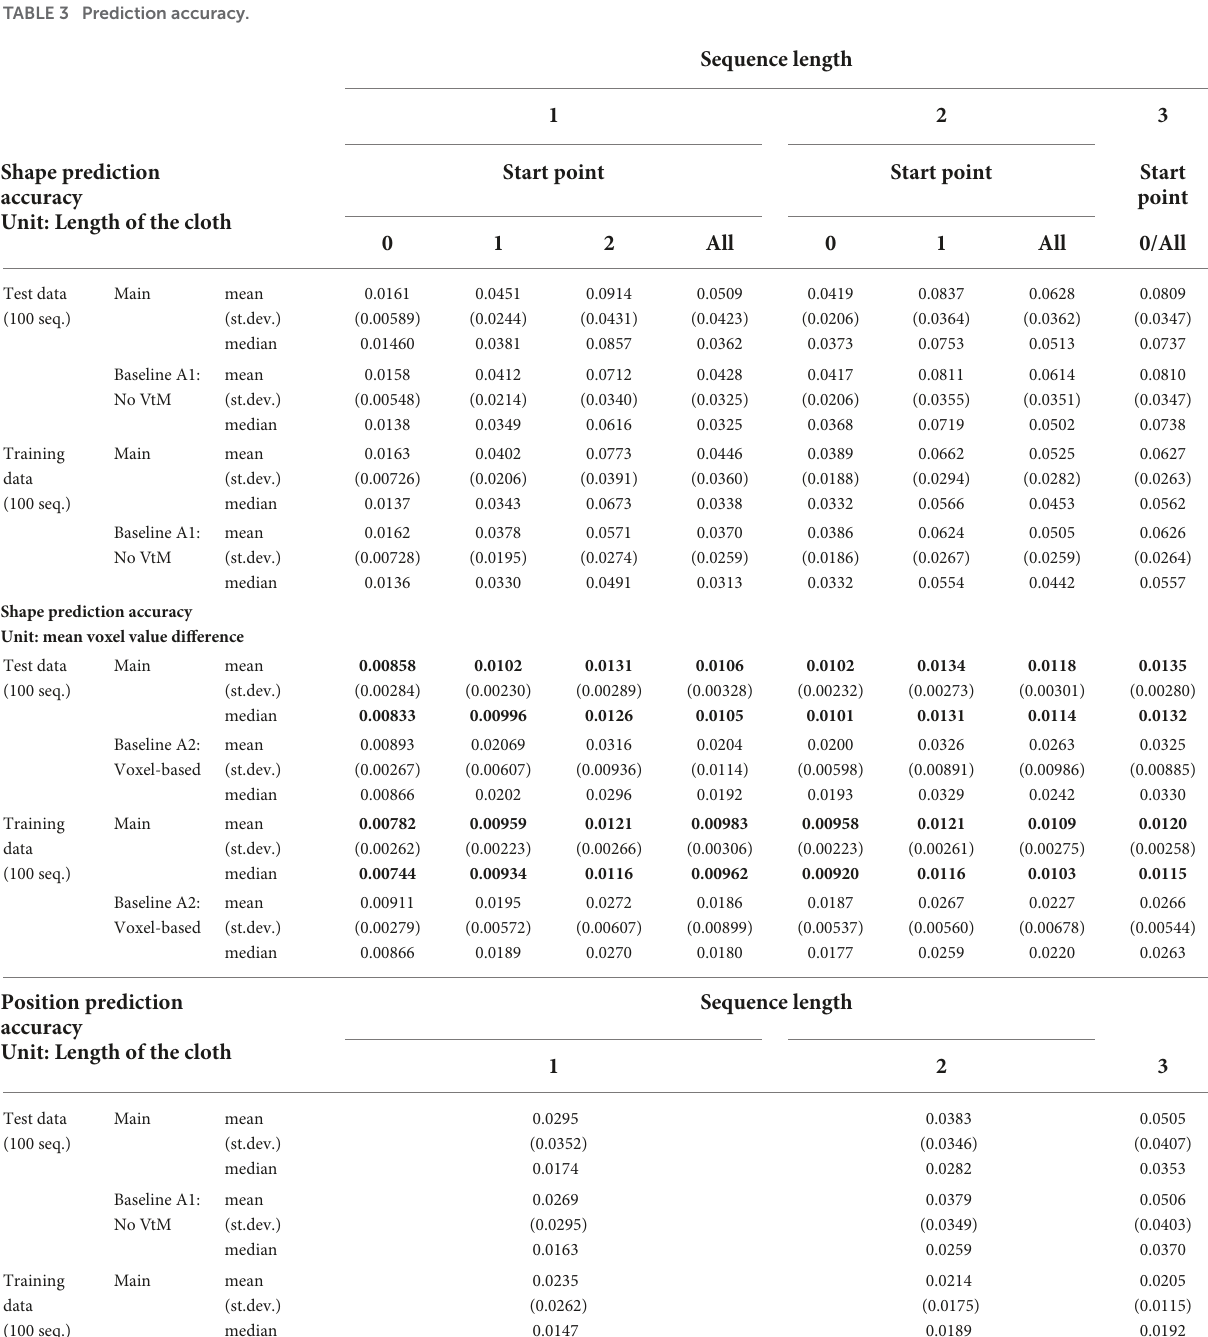
TABLE 3 Prediction